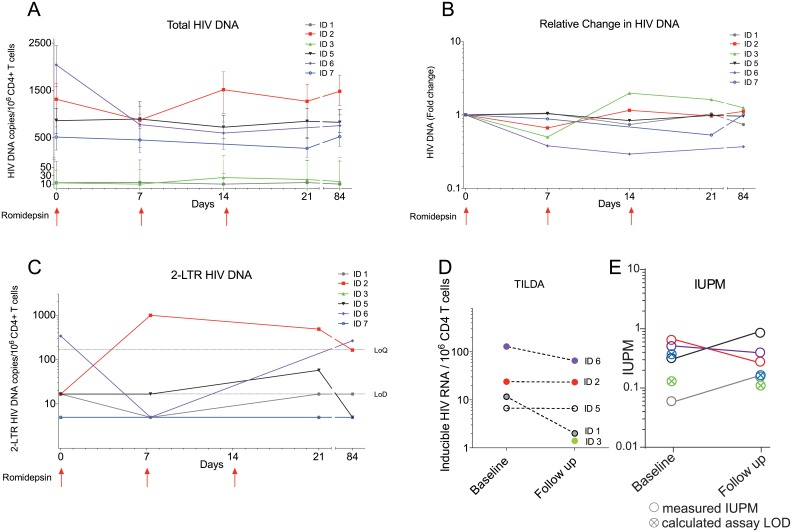
The size of the HIV-1 reservoir was unchanged by romidepsin.Panels (A) to (E) show measures of the size of the viral reservoir as well as in the inducible HIV-1 reservoir during romidepsin treatment. (A) Absolute levels of total HIV-1 DNA per 106 CD4+ T cells. (B) Fold changes in total HIV-1 DNA per 106 CD4+ T cells. (C) Absolute levels of 2-LTR HIV-1 DNA per 106 CD4+ T cells. (D) Frequency of cells with multiply spliced HIV RNA upon maximal cellular activation with PMA/ionomycin as measured using a tat/rev induced limiting dilution assay (TILDA). (E) shows results from a quantitative viral outgrowth assay (qVOA) which was used to assess the frequency of resting CD4+ cells carrying inducible replication competent proviruses at baseline and day 56. LoQ, limit of quantitation; Lod, limit of detection; IUBM, infectious units per million.